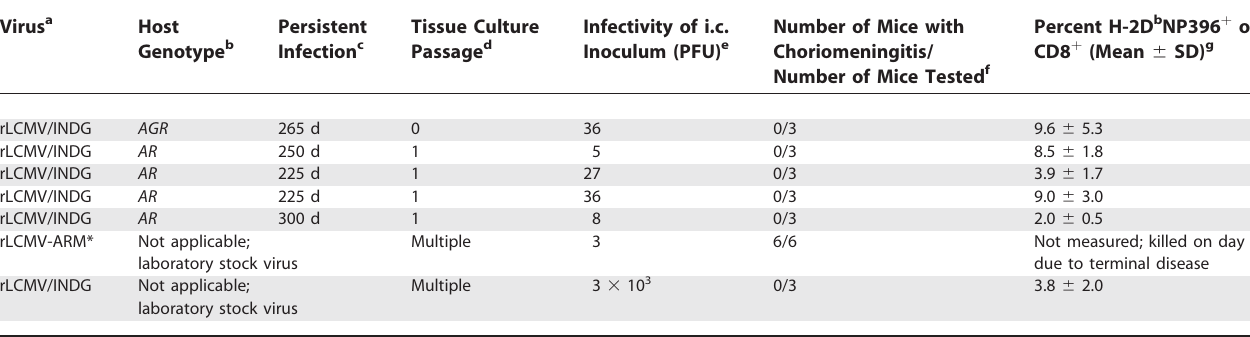
Table 3. No Detectable Gain in rLCMV/INDG Pathogenicity after Propagation in Immunodeficient Hosts Virus